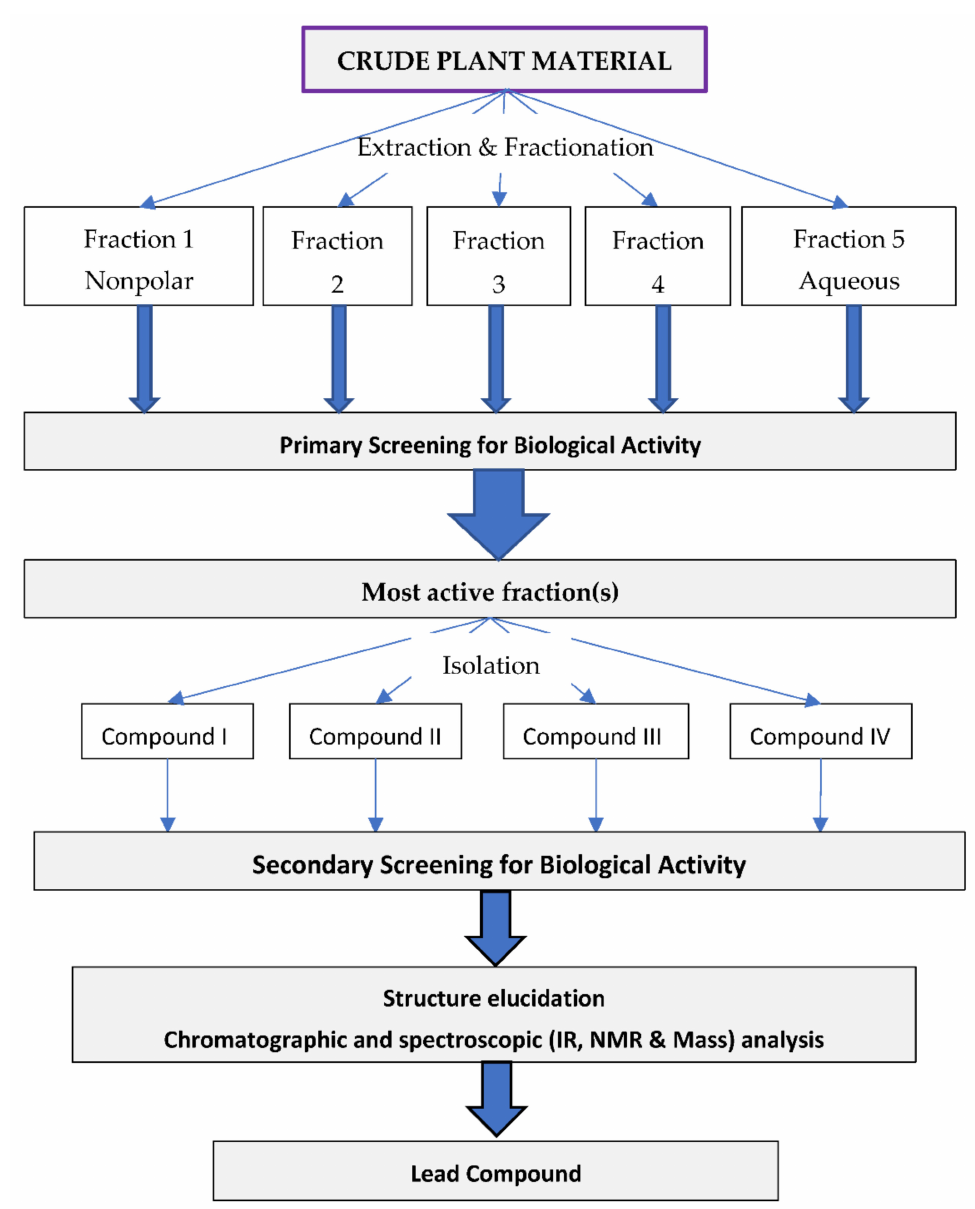
Figure 3. An outline of sequential approach for biological activity guided fractionation of plant